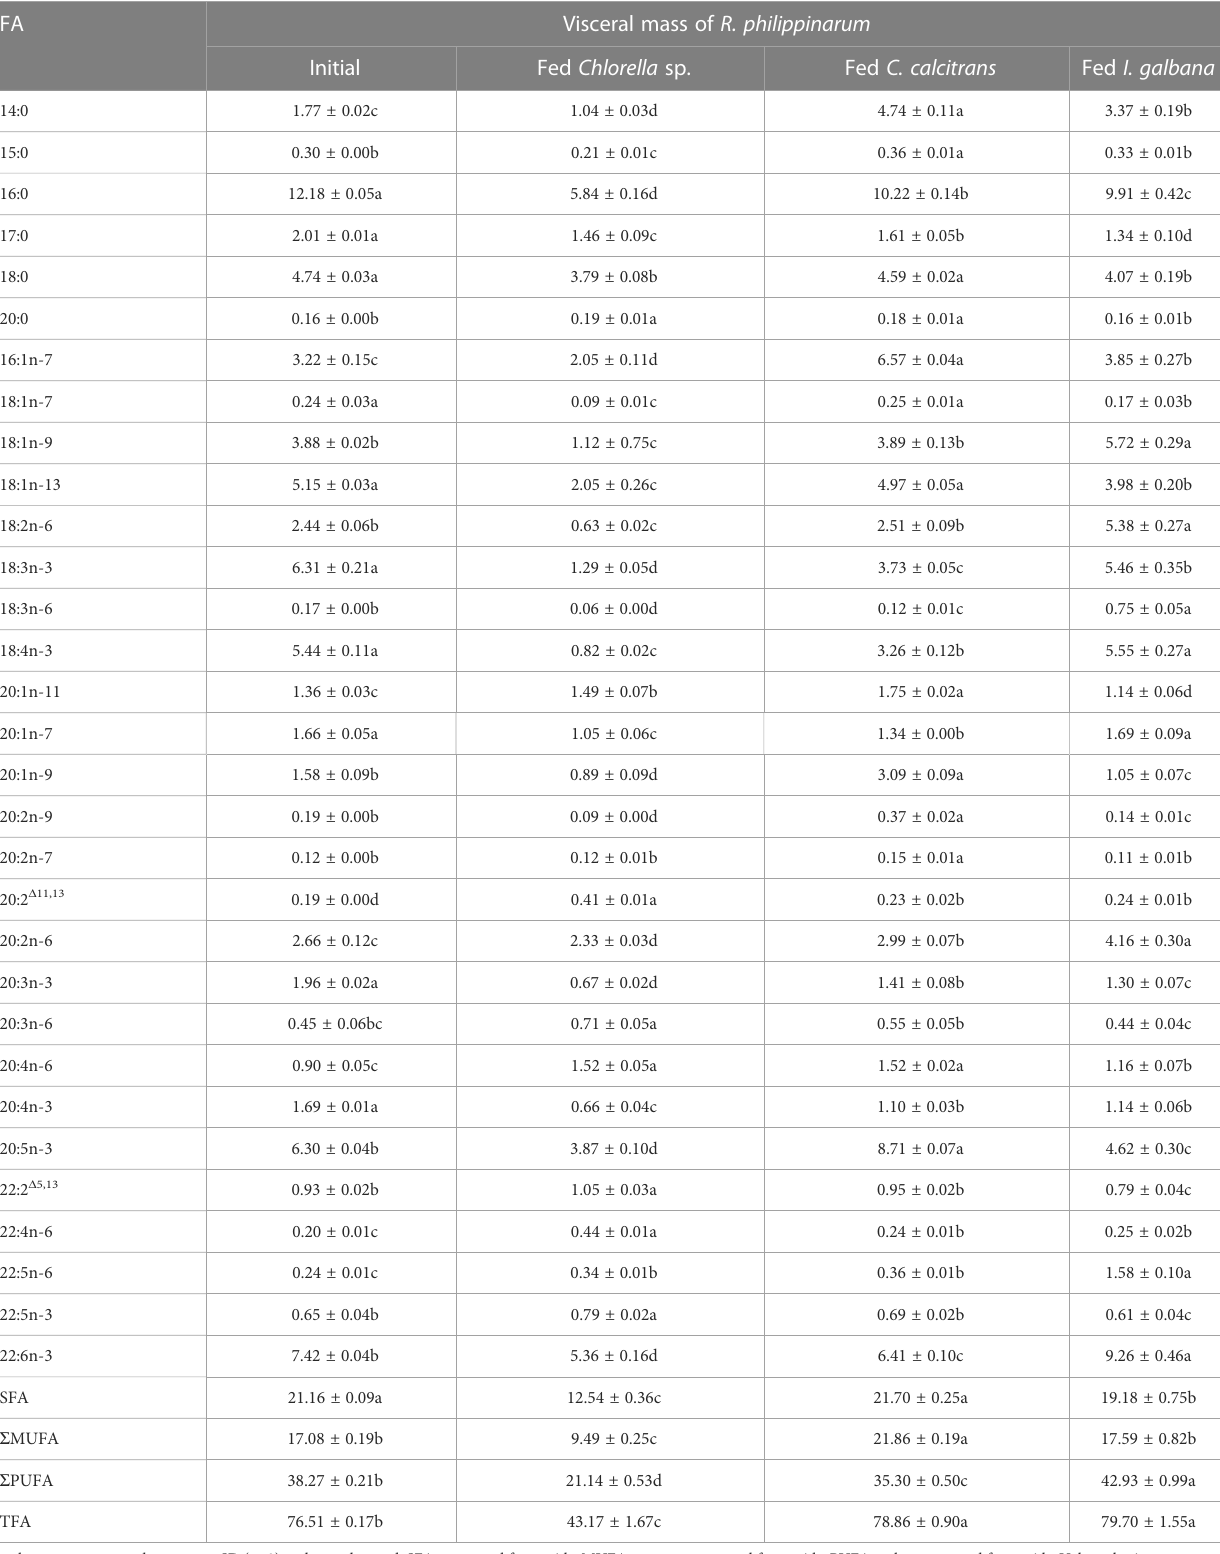
Results were represented as mean ± SD (n=3). n.d., not detected; SFA., saturated fatty acids; MUFA., monounsaturated fatty acids; PUFA, polyunsaturated fatty acids. Values sharing a common letterinthesamegrouparenotsigni fi cantlydifferent(P ≥ 0.05).SFA,saturatedfattyacids;MUFA,monounsaturatedfattyacids;PUFA,polyunsaturatedfattyacids(doublebonds ≥ 2);TFA,total fatty acid; “ n.d. ” , not